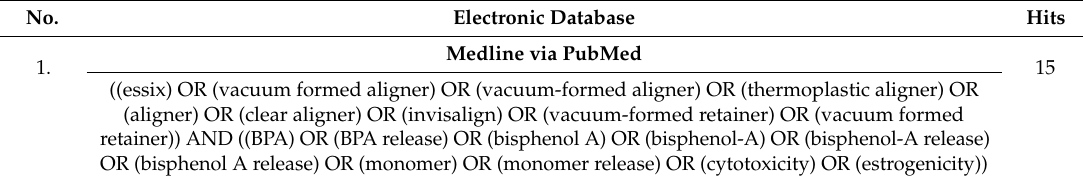
Table S1: Detailed assessment of included randomized trials with the RoB 2.0 tool (supplement to Table 2). Table S2: